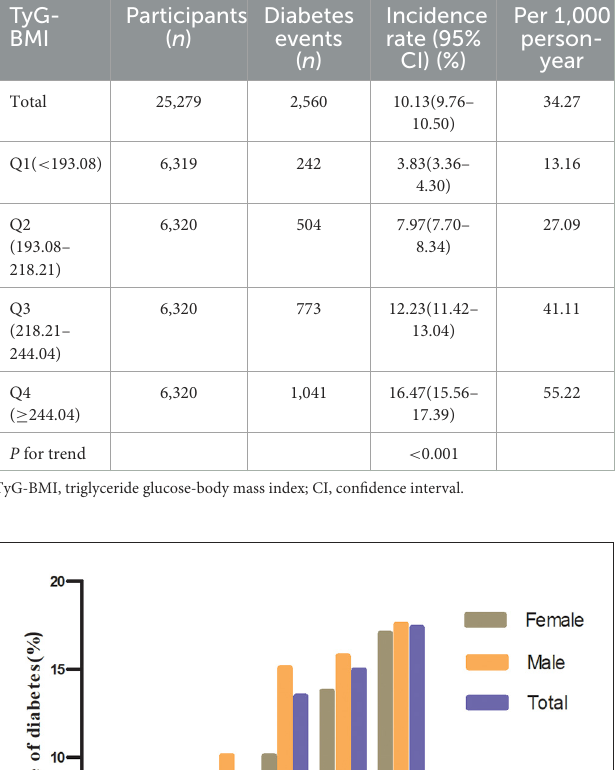
TABLE 2 Incidence rate of diabetes in participants with prediabetes (% or Per 1,000 person-year).